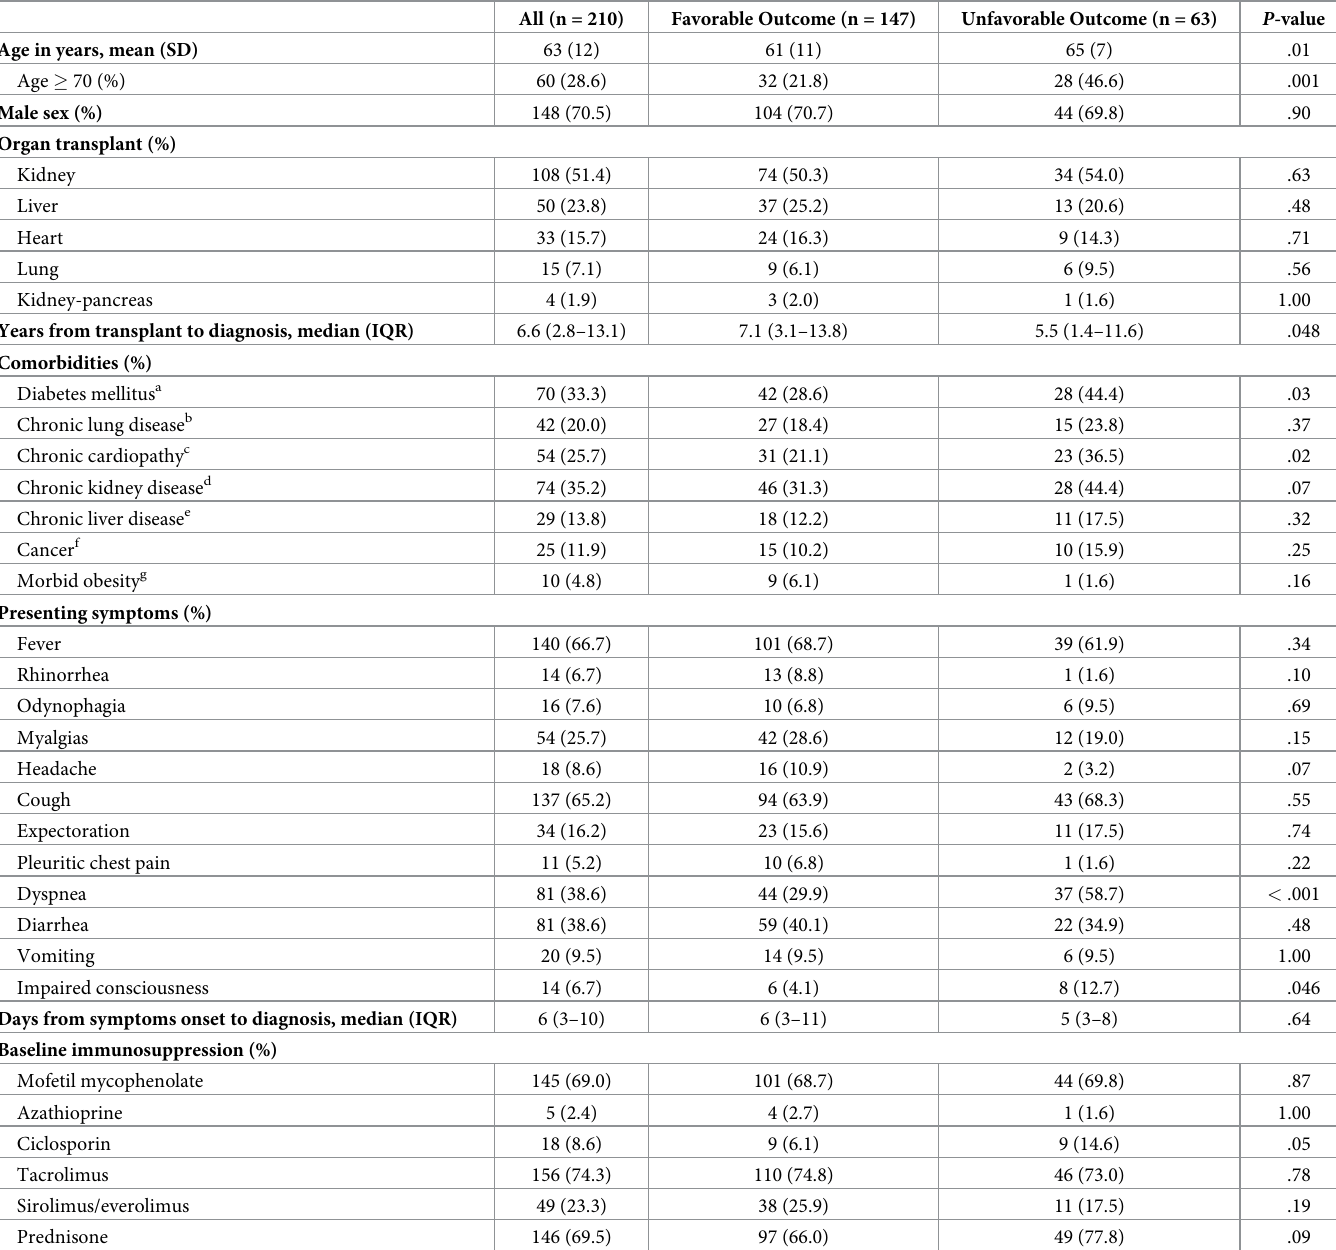
Table 1. Demographics, comorbidities, clinical data, and baseline immunosuppression in all patients and by clinical outcome at final